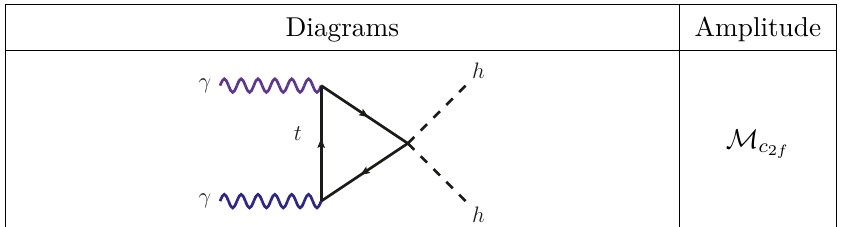
Table 2 . The 3 benchmarks for the Higgs couplings as a function of ξ = v 2 /f 2 ≡ sin 2 θ , with θ the misalignment angle [29, 30].